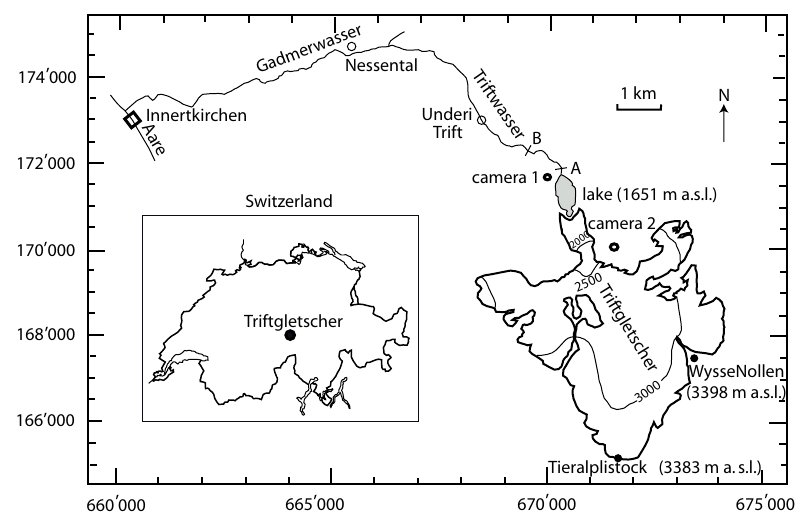
Fig. 1. Map of Triftgletscher with the locations of 2 automatic cameras.